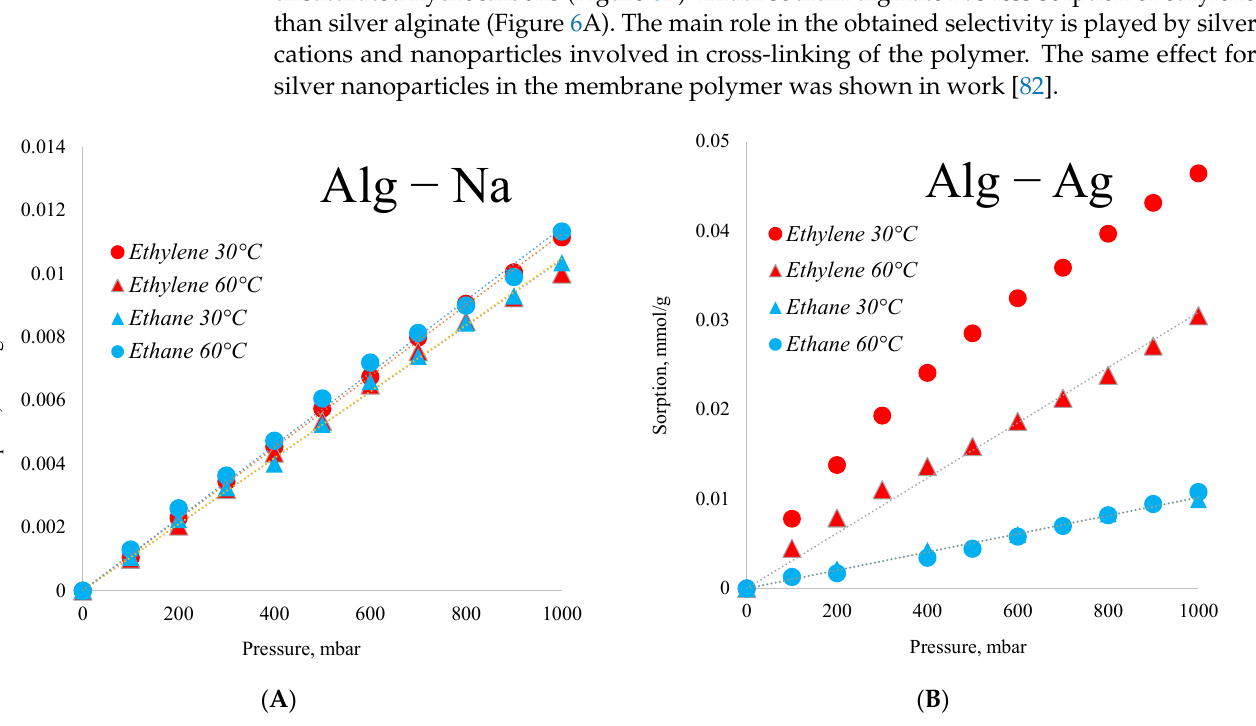
Figure 6. Sorption of ethane and ethylene by sodium alginate ( A ) and silver alginate ( B ) samples.